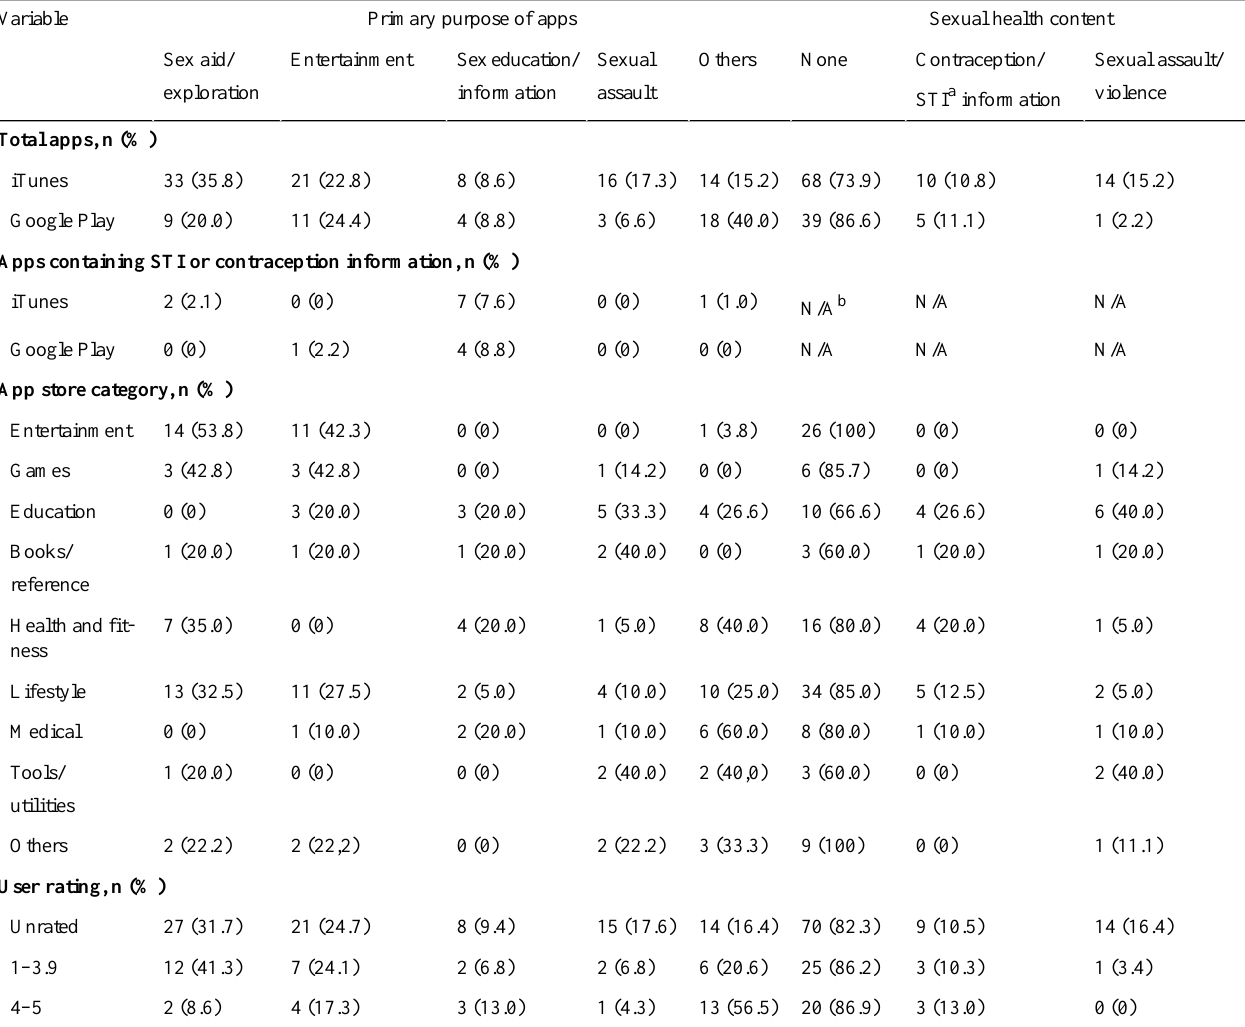
Table 1. Sexual health content of sex-related apps (N=137).